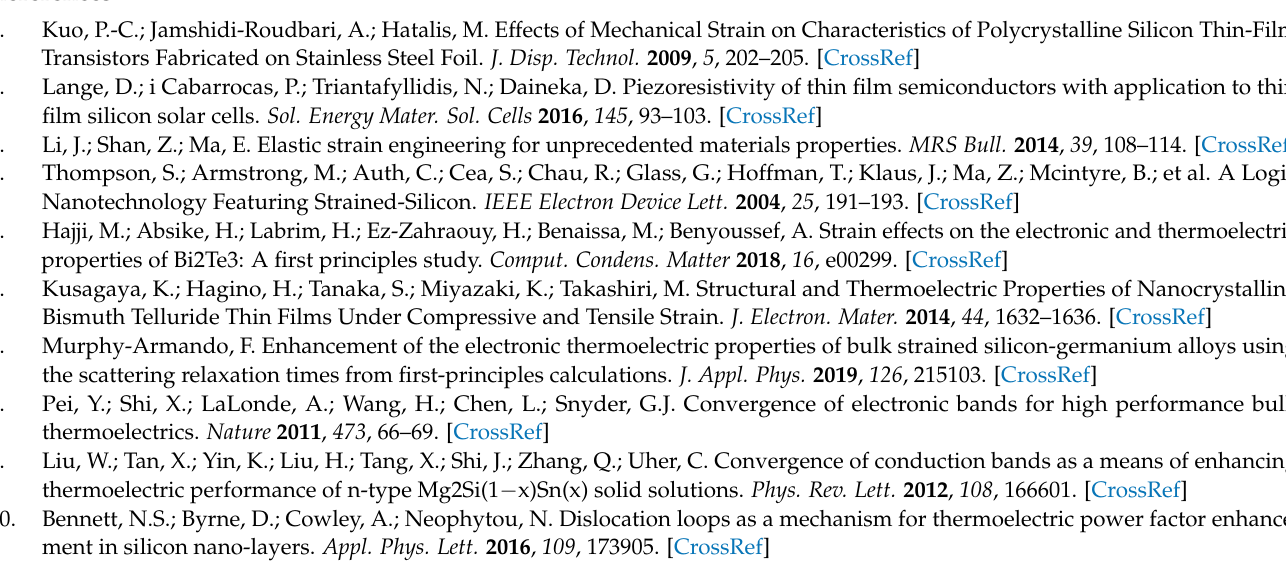
Figure S4: Example of the temperature dependence of the Seebeck coefficient in the range from room temperature up to 60 ◦ C for n-type samples bent at a radius of 10.3 mm in a) tensile strain b) compressive strain; Figure S5: Temperature dependence of the Seebeck coefficient for p-type samples measured in the range from room temperature up to 60 ◦ C under (a) tensile strain, and (b) compressive